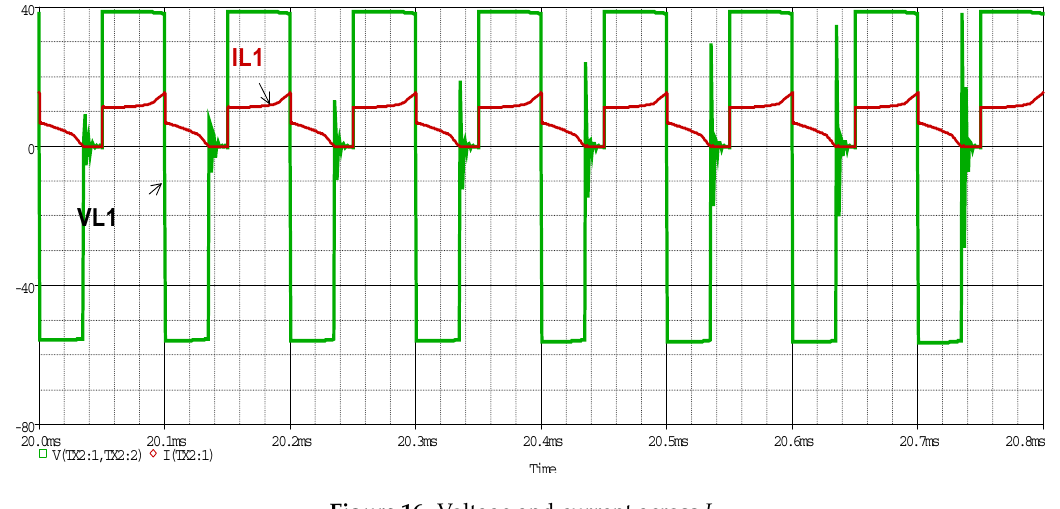
Figure 16. Voltage and current across L 1 .